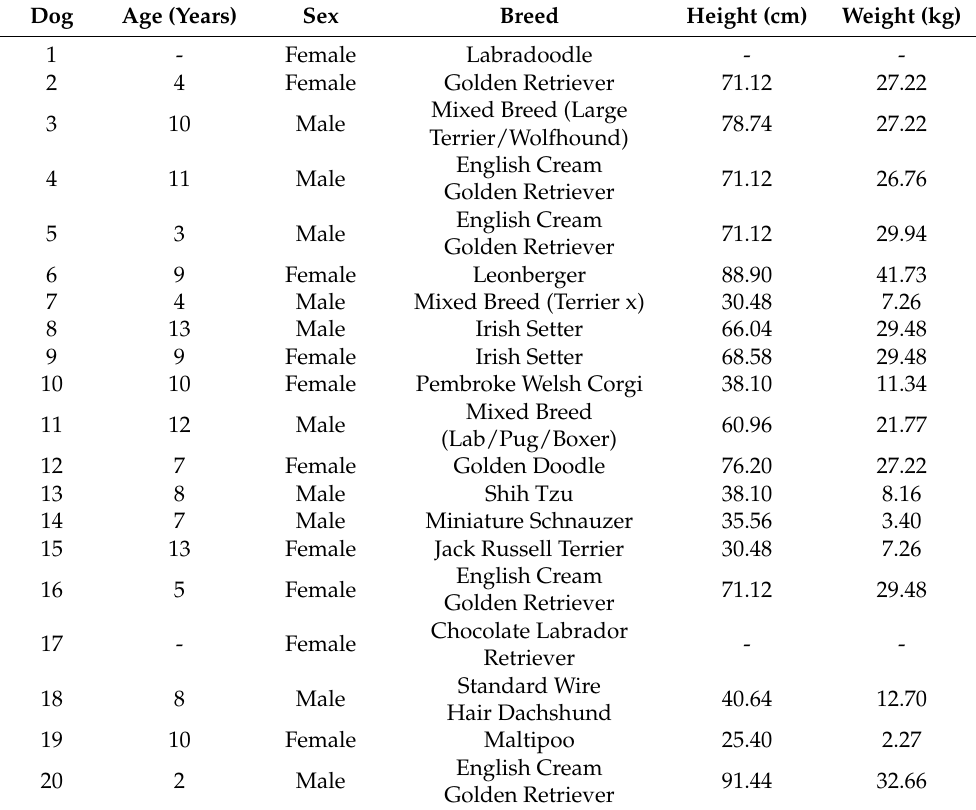
Table 3. Characteristics of Dogs on Call therapy dogs observed during the quality assurance study